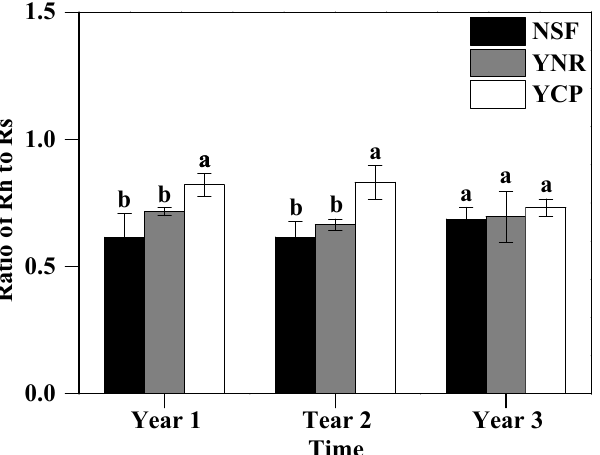
Figure 4. Mean (± standard deviation) ratio of heterotrophic respiration (Rh) to total respiration (Rs) in the first three years following a reforestation experiment in a mature, natural secondary forest (NSF), a young forest established through assisted natural regeneration (YNR), and a young Castanopsis carlesii plantation (YCP). For the first year, only data for the second half of the year were used to account for transient effects caused by the decomposition of dead roots. Different letters indicate significant different between forests at p < 0.05. For a given period, forests sharing no common letters are significantly different at p < 0.05.